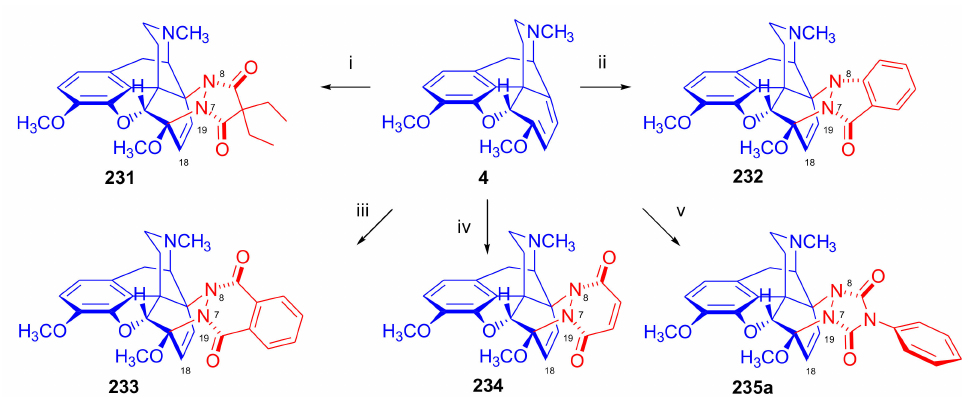
Figure 63. Diels–Alder adducts of thebaine with azaoxo-dienophiles. Reagents and conditions : (i) 4,4-diethyl-pirazolidine-3,5-dione, (A) oxidation with LTA, CH 2 Cl 2 , room temperature, 2 h; or (B) oxidation with tert -butylhypchlorite, acetone, (1) -70 ◦ C, (2) room temperature (ii): 3-indazolone; (iii): 1,4-dihydrophthalazine-1,4-dione; (iv): 1,4-dihydopyridazine-3,5-dione; and (v): PTAD.